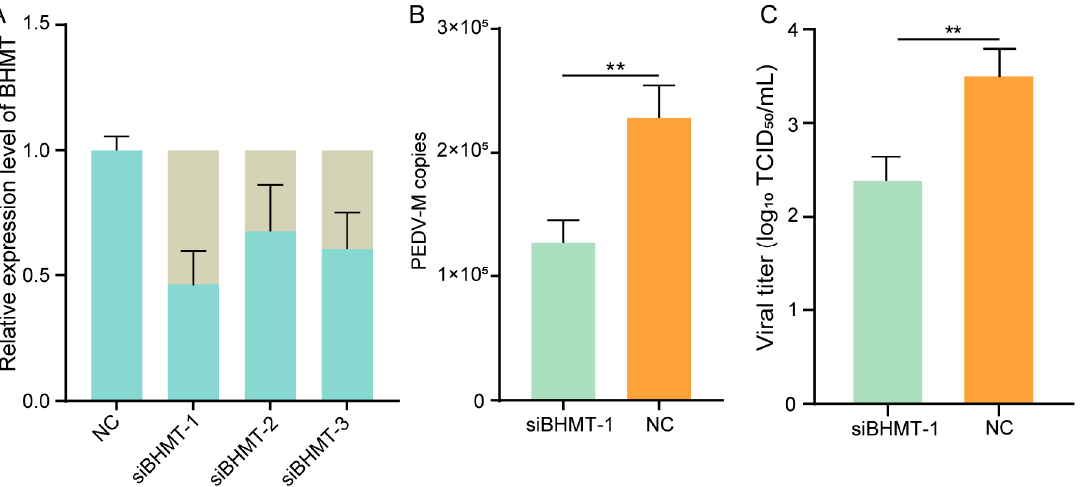
Figure 4. BHMT regulates the infection of PEDV with IPEC-J2 cells. ( A ) Interference efficiency of siRNAs targeting BHMT quantified by qRT-PCR. siBHMT-1, siBHMT-2, and siBHMT-3 indicate three different siRNAs. NC: negative control. The sandy and light blue respectively denote the interference efficiency and expression efficiency of the BHMT gene. ( B ) Genome copy numbers of PEDV in BHMT knockdown and control cells. siBHMT-1: knockdown of BHMT by siRNA siBHMT-1; NC: negative control. ( C ) Viral titer of PEDV in BHMT knockdown and control cells. siBHMT-1: knockdown of BHMT by siRNA siBHMT-1; NC: negative control. Values are presented as mean ± standard derivation. ** p < 0.01.